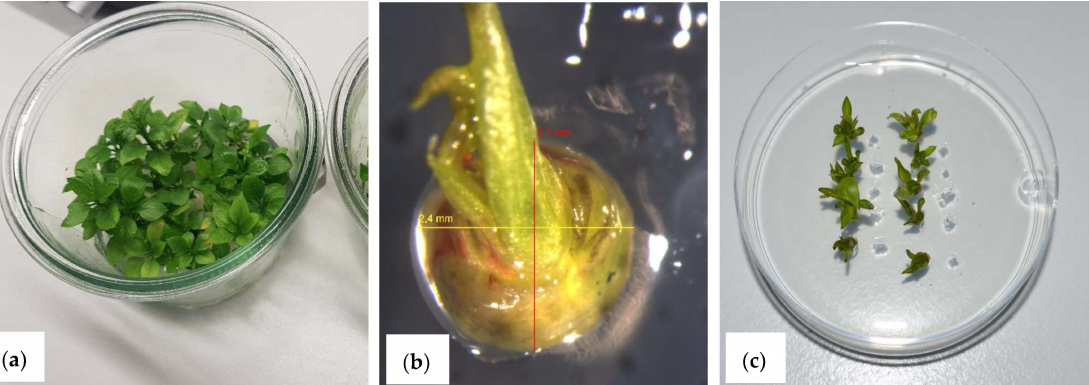
Figure 2. Cryopreservation of Pyrus by using PVS2 vitrification: ( a ) Donor material in vitro shoots; ( b ) Explant of P. korshinskyi- shoot tip with four primordia; ( c ) Recovery of P. × bretschneideri shoot tips after cryopreservation.